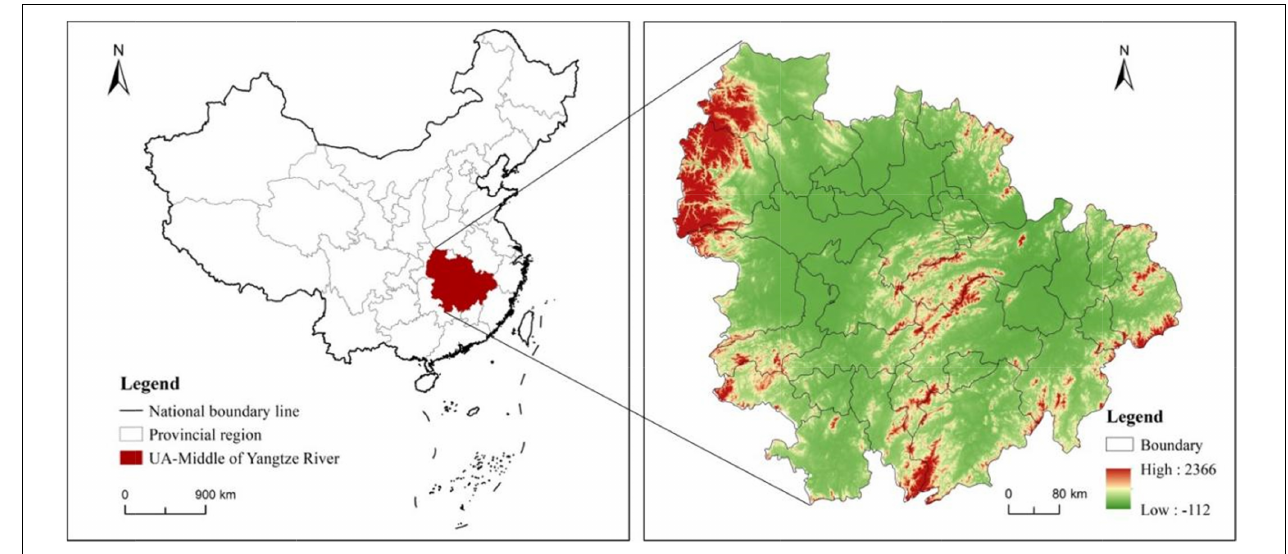
FIGURE 1 | Location of the study area and its basic